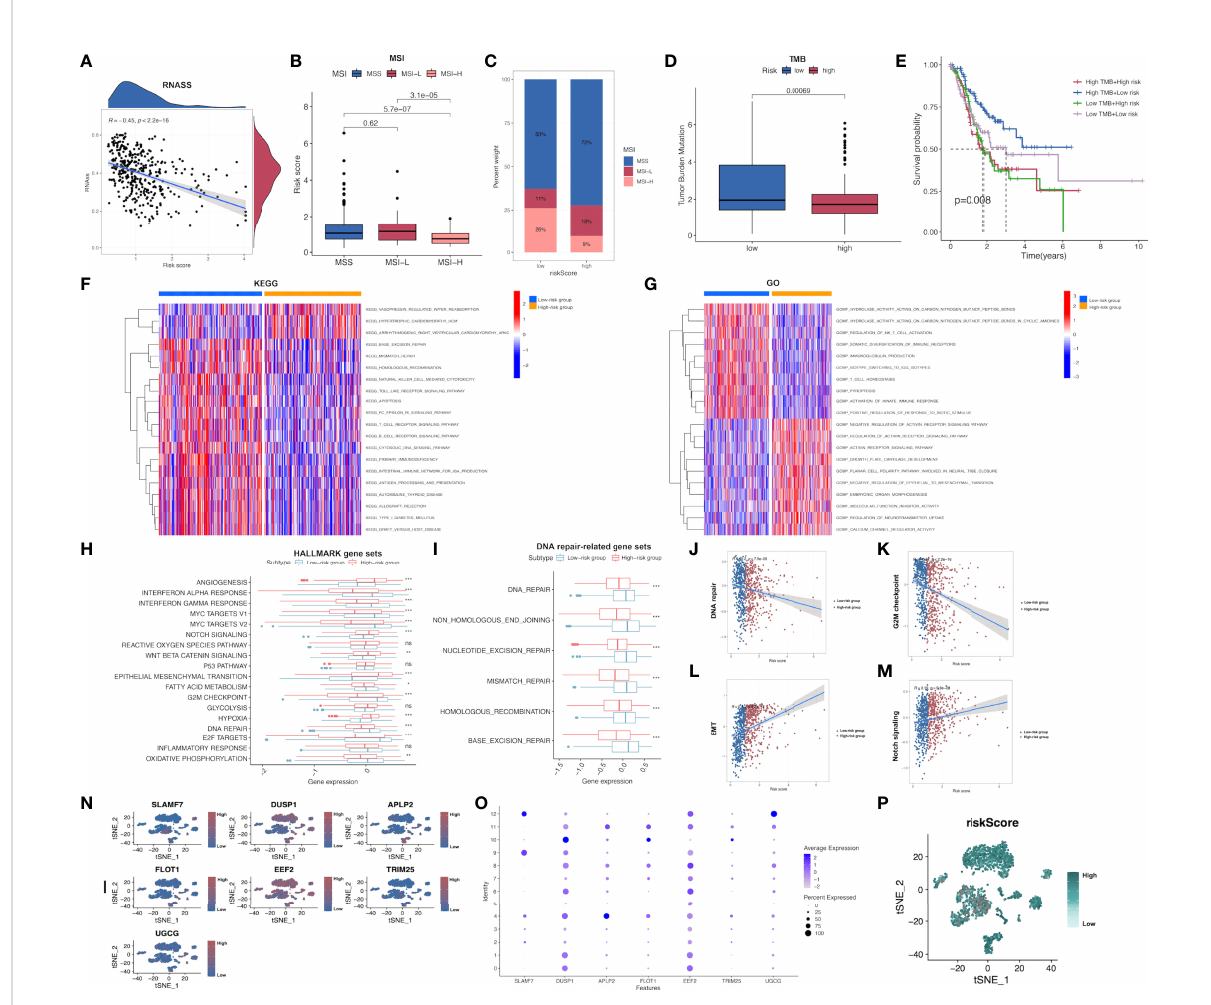
FIGURE 6 Comprehensive comparison of the differences between high- and low-risk groups screened by our immune-related model. (A) Relationships between risk score and CSC index. (B, C) Relationships between risk score and MSI. (D) TMB in low- and high-risk groups in STAD-GSE84437. (E) Relationships between TMB and prognosis of GC patients in STAD-GSE84437. (F) Differential enrichment of KEGG pathways between low- and high-risk groups in STAD-GSE84437. (G) Differential enrichment of GO annotations between low- and high-risk groups in STAD-GSE84437. (H) Differential enrichment of Hallmark pathways between low- and high-risk groups in STAD-GSE84437. (I) Differential enrichment of DNA repair-related pathways between low- and high-risk groups in STAD-GSE84437. (J – M) Spearman correlation analysis between risk scores and DNA repair, G2M checkpoint, EMT and Notch signaling, respectively. (N, O) The expression of seven model genes in the primary GC tissues in scRNA-seq dataset GSE163558. (P) The distribution of risk scores of different cells in primary GC tissues in GSE163558. CSC, cancer stem cell; TMB, tumor mutation burden; MSI, microsatellite instability; GO, Gene Ontology; KEGG, Kyoto encyclopedia of genes and genomes; GC, gastric cancer; STAD, stomach adenocarcinoma; EMT, epithelial-mesenchymal transition; scRNA-seq, single-cell RNA sequencing. *P<0.05; **P<0.01;